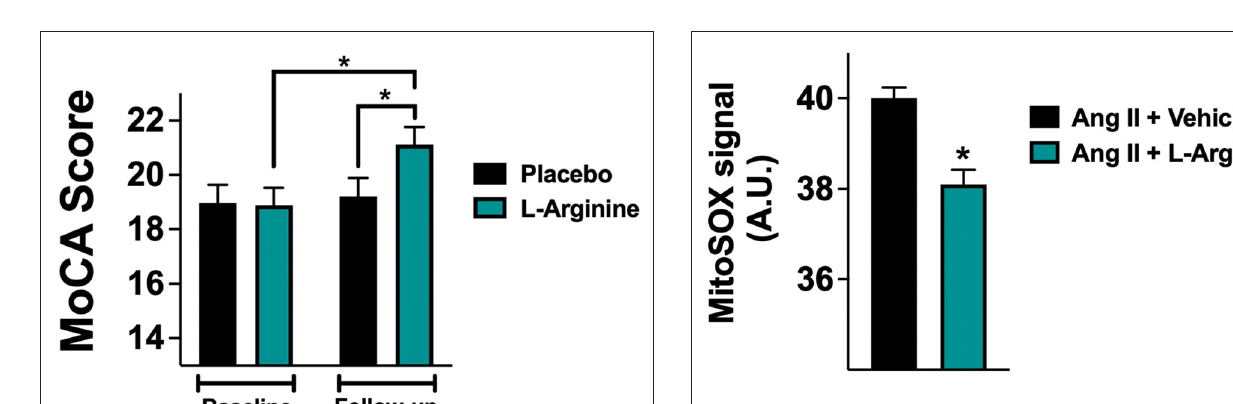
FIGURE 3 | Mitochondrial production of reactive oxygen species (ROS) evaluated in human endothelial cells treated with Angiotensin II (Ang II) (1 µ M) + vehicle or Ang II + L-Arginine (500 µ M) for 24 hours; A.U., arbitrary units. Data are means ± SE; *: p <